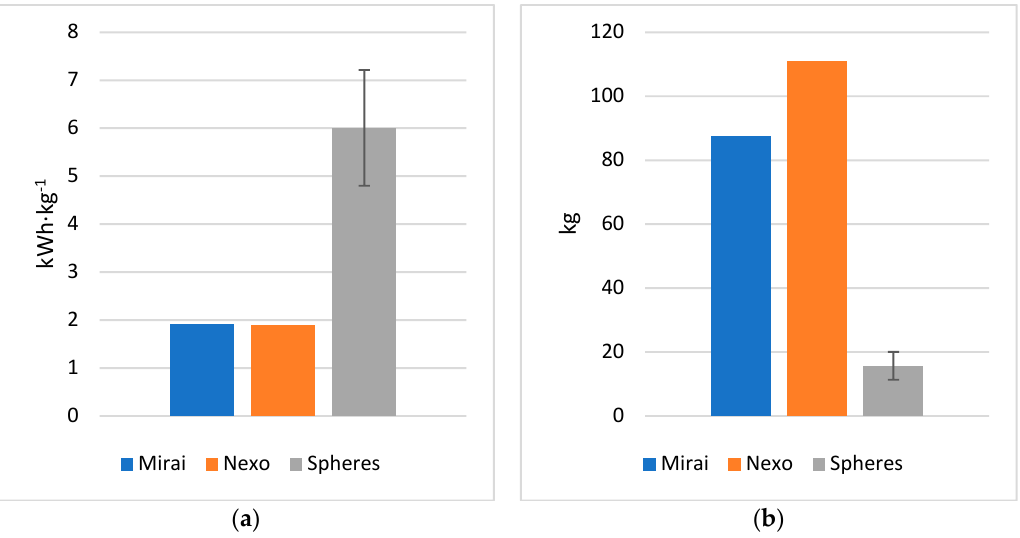
Figure 11. Comparison between the system under study and the storage systems of Toyota Mirai and Hyundai Nexo, regarding the ( a ) GED and ( b ) total system mass.